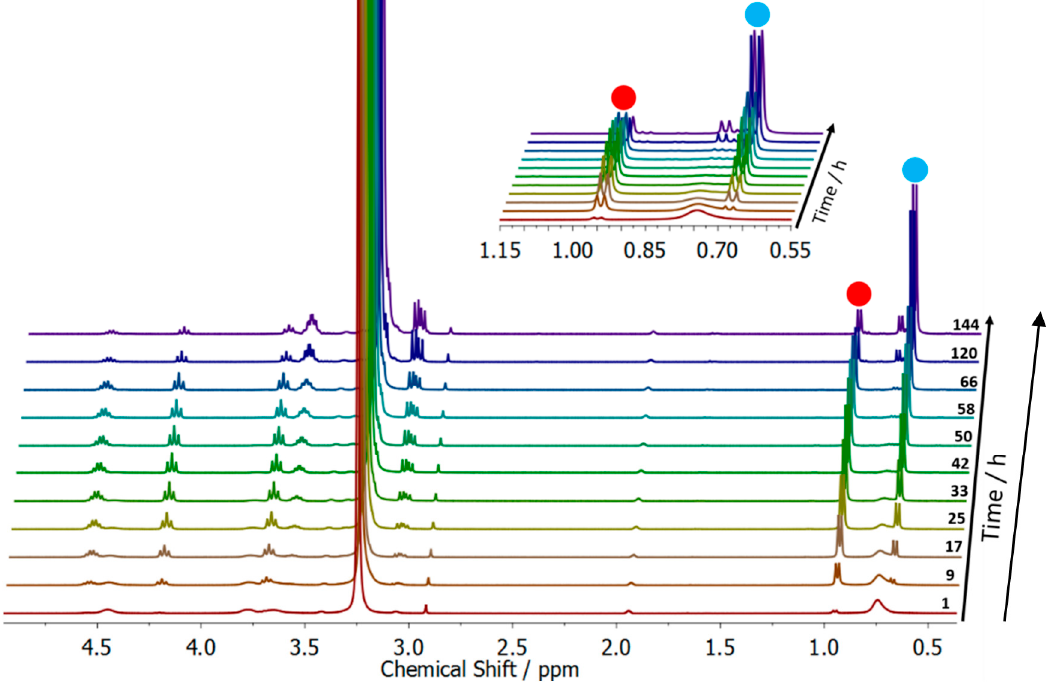
Figure 4 . Selected spectra of the online 1 H-NMR degradation kinetics of mPEG 113 - b -PPC 49 (Table 1, sample 3) in conc. DCl (400 MHz) Bottom: overlay of spectra of the online 1 H-NMR kinetic study. Top: zoom in, showing the increase and decrease of the methyl signals of propylene carbonate (red dot) and propane-1,2-diol (blue dot).